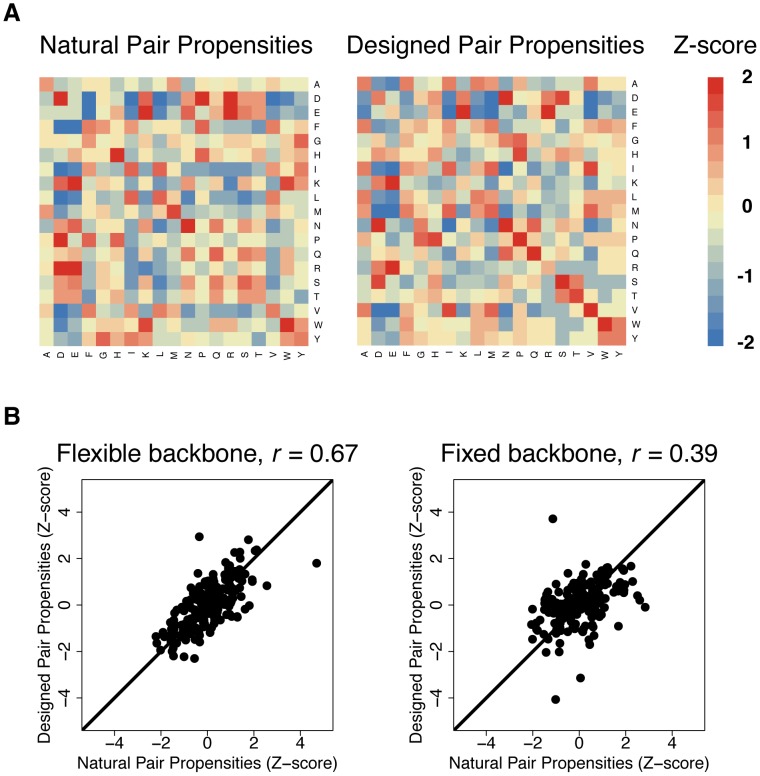
Correlation of amino acid pair propensities between natural and designed covarying pairs.A) Heat maps of amino acid pair propensities at pairs of positions that are highly covarying in both designed and natural sequences. Red pairs are over-represented at covarying positions and blue pairs are under-represented at covarying positions. The values are shown as Z-scores, which denote the number of standard deviations above or below the mean. B) Correlation of amino acid pair propensity Z-scores between designed and natural sequences. The left plot shows the correlation from flexible backbone design sequences and the right plot shows the correlation from fixed backbone design sequences. A Pearson correlation coefficient (r) is shown for each plot.